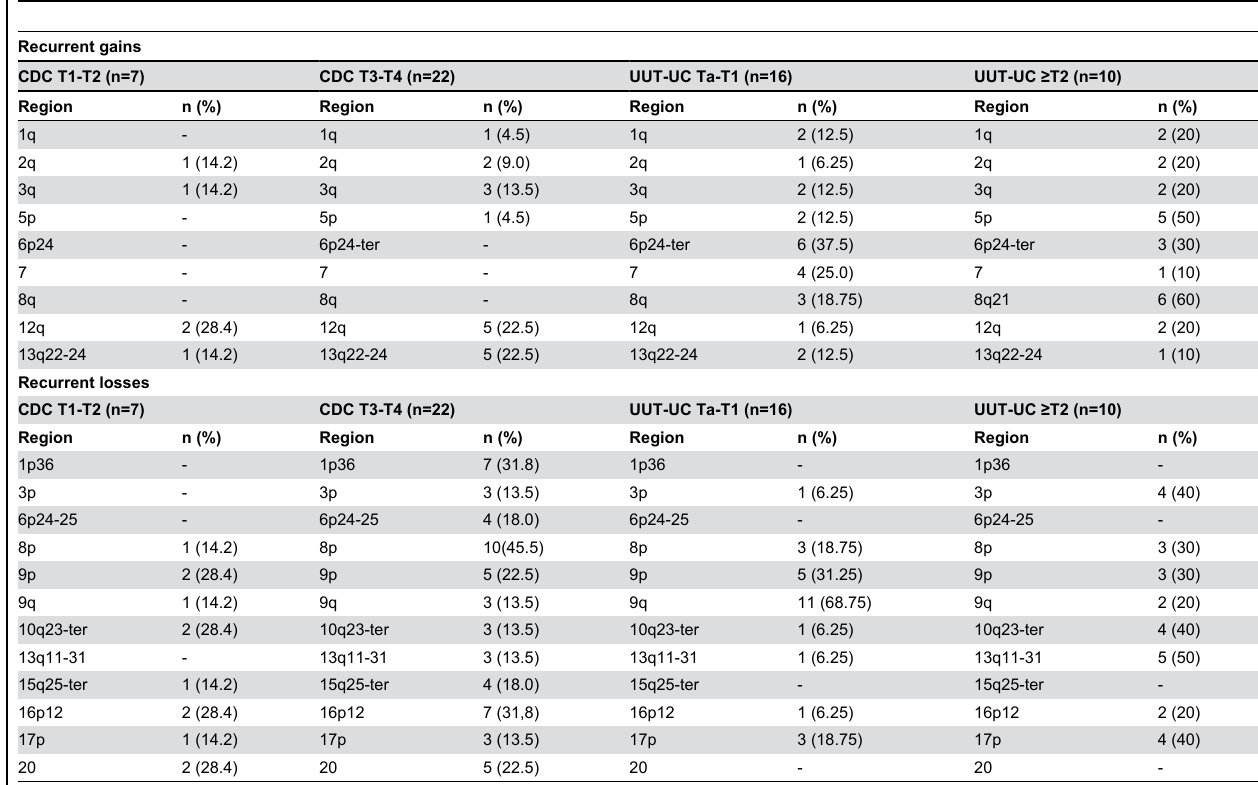
Table 4. Comparison of the most common aberrations and their frequencies in CDC and UUT-UC tumors.